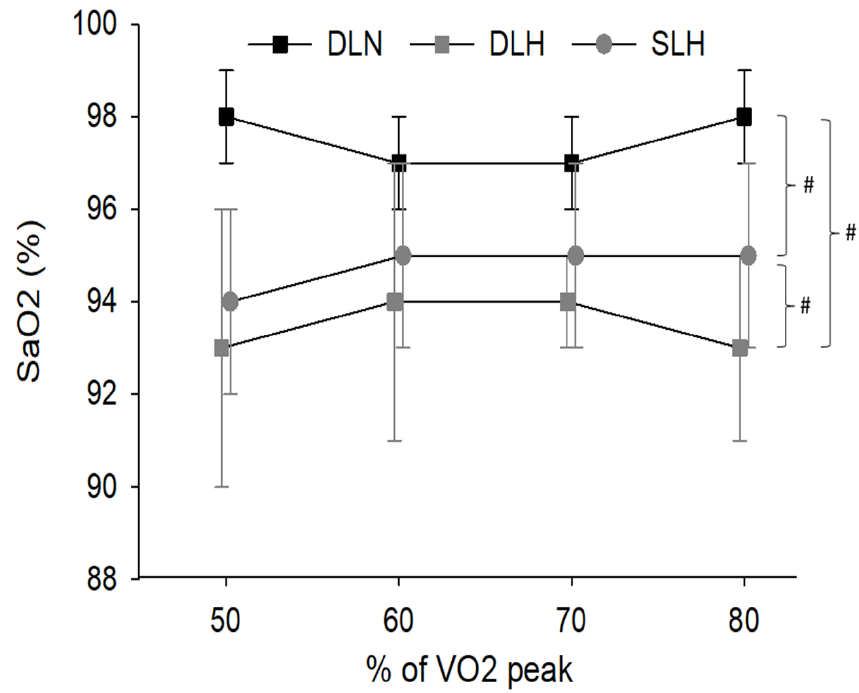
Figure 5. Changes in SaO2 concentrations across the four different work rates. # Indicates signifi- cantly different SaO2 concentrations for main effect of condition ( p ≤ 0.05). DLN = Double-Leg Normoxia; DLH = Double-Leg Hypoxia; SLH = Sigle-Leg Hypoxia. Lactate Cycling condition (F (2, 18) = 19.93, p < 0.001) and work rate (F (3, 27) = 21.93, p < 0.001) had main effect on lactate but not their interaction (F (6, 54) = 1.05, p = 0.407) (Figure 6). Specifically, lactate was not significantly different between 50 and 60% VO 2 peak ( p = 0.903) but then increased from 60% to 70% VO 2 peak ( p = 0.003) and again from 70% to 80% VO 2 peak ( p < 0.001). Additionally, with regard to the main effect of condition, lactate during DLH was greater than DLN ( p = 0.002) which was greater than SLH ( p = 0.045).